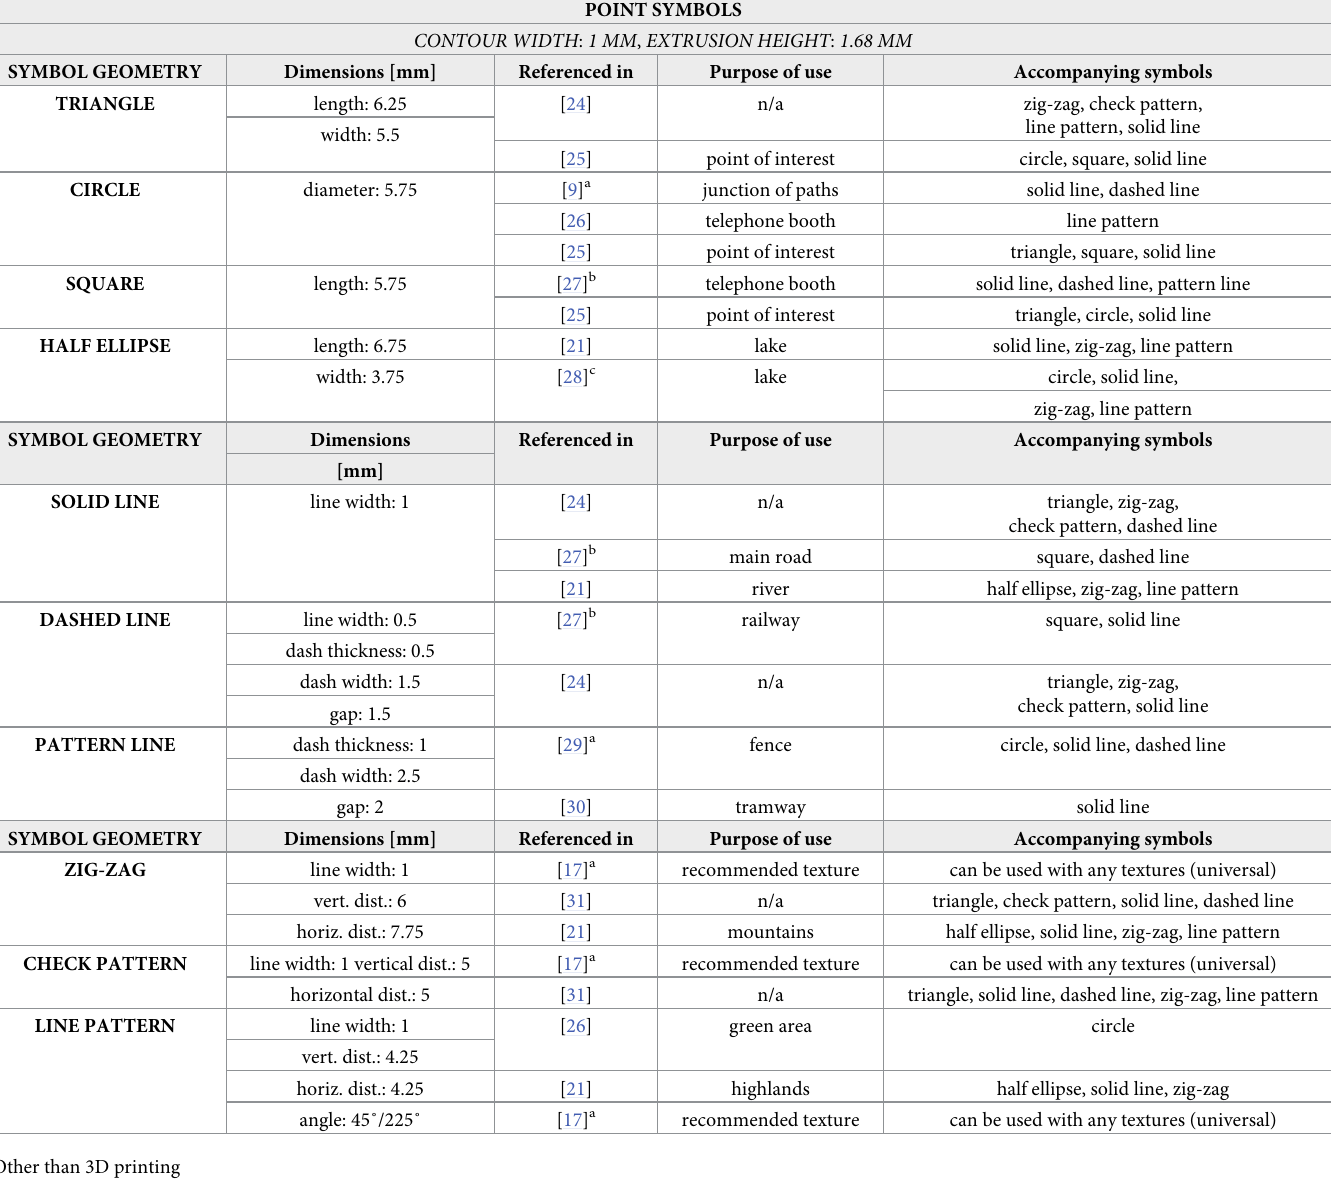
Table 2. The symbols used in the